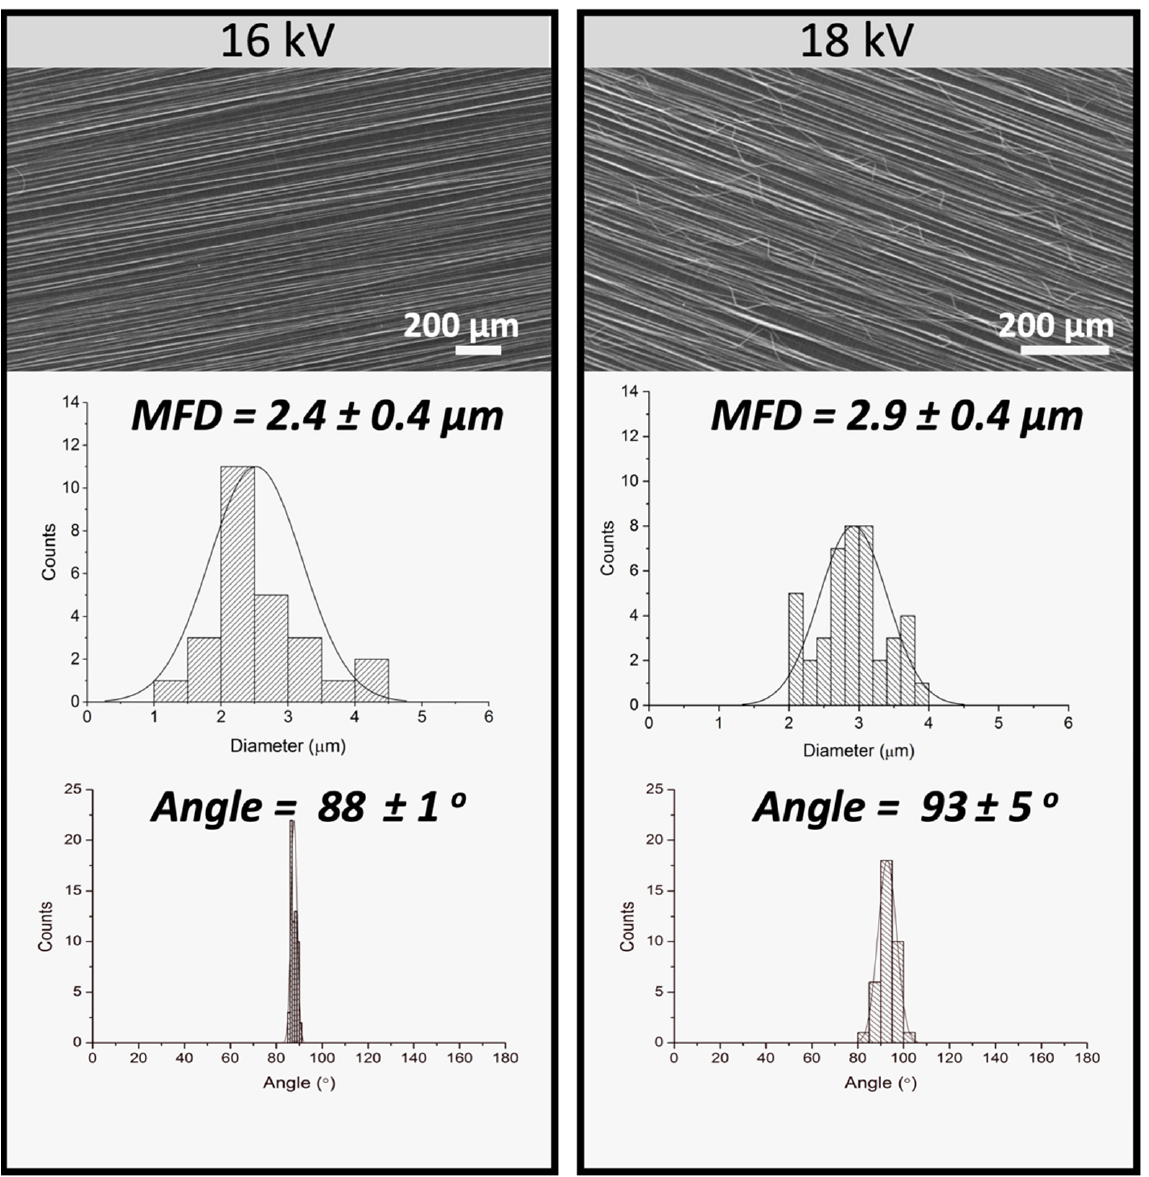
Figure 6. SEM micrographs (row 1) corresponding to PLA fibers (20% PLA, 90:10 CHCl 3 :DMF) obtained applying different voltages: 16, 18 kV, and their respective histograms corresponding to mean fiber diameter (row 2) and orientation (row 3). (Electrospinning fixed parameters: 1.0 mL/h feed rate, needle-to-collector distance 12 cm and rotor velocity 1300 rpm).